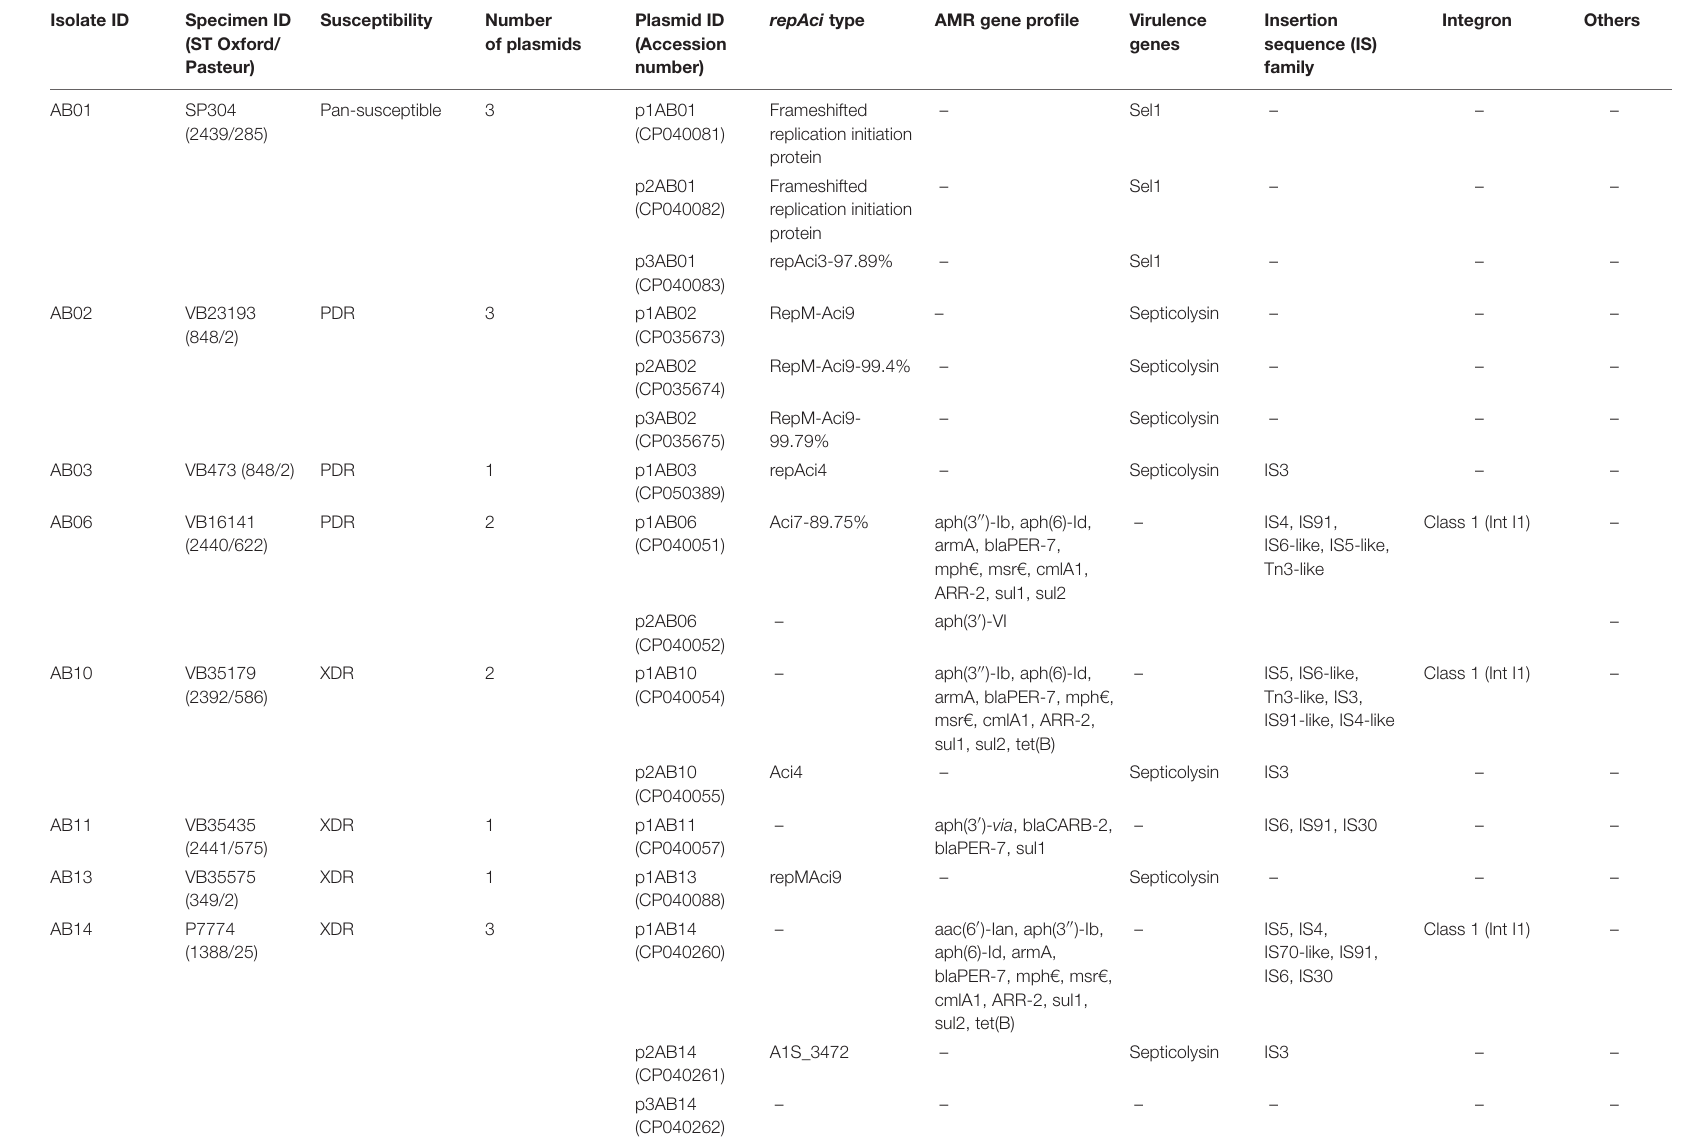
TABLE 3 | Characteristic features of plasmids among the 17 complete genomes of Acinetobacter baumannii. Isolate